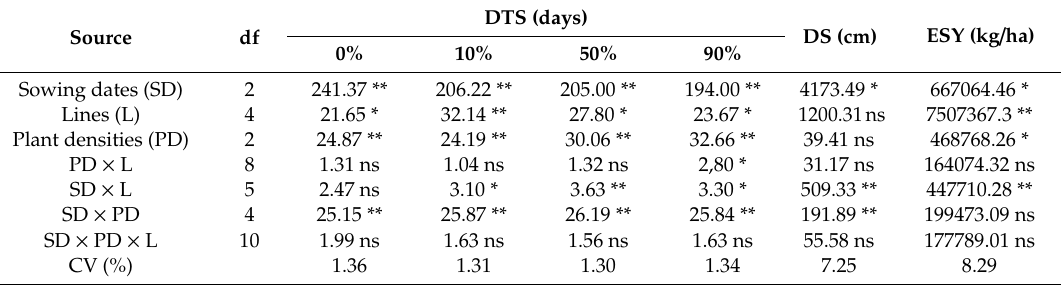
Table 5. Mean squares of the combined ANOVA of Experiment 2.